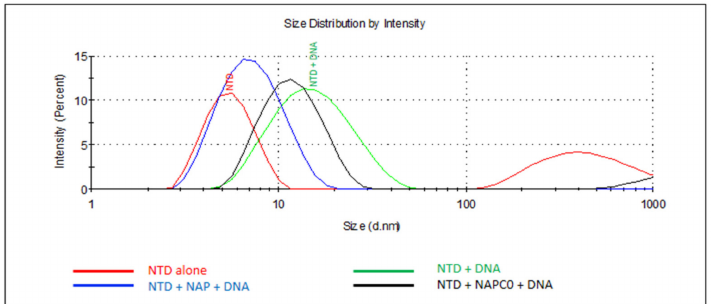
Figure 5. Naproxen competes with DNA-induced N oligomerization. Size distribution of N NTD alone (red) or in the presence of 48 mer DNA (green), demonstrating the DNA-induced oligomer- ization of N NTD. Naproxen (blue) addition to N largely impeded N NTD oligomerization while naproxen C0 (black) only somewhat decreased the size of the N-DNA complex. The sizes are de- scribed in the text. T = 20 ◦ C, [NTD] = 60 µ M, [48mer DNA] = 29.4 µ M and naproxen or naproxen C0 were used at 37.5 µ M. In these conditions, naproxen A or acetaminophen could not impede N oligomerization (Table